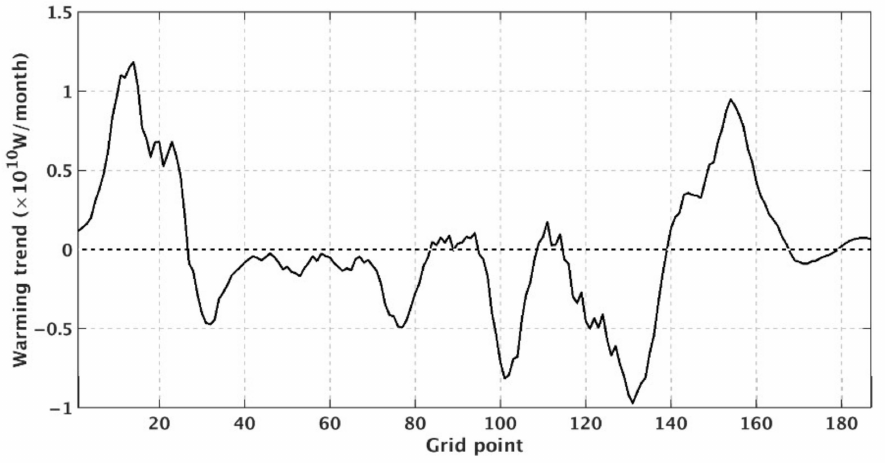
Figure 8. The trend of vertical-integrated heat transport at each point along the